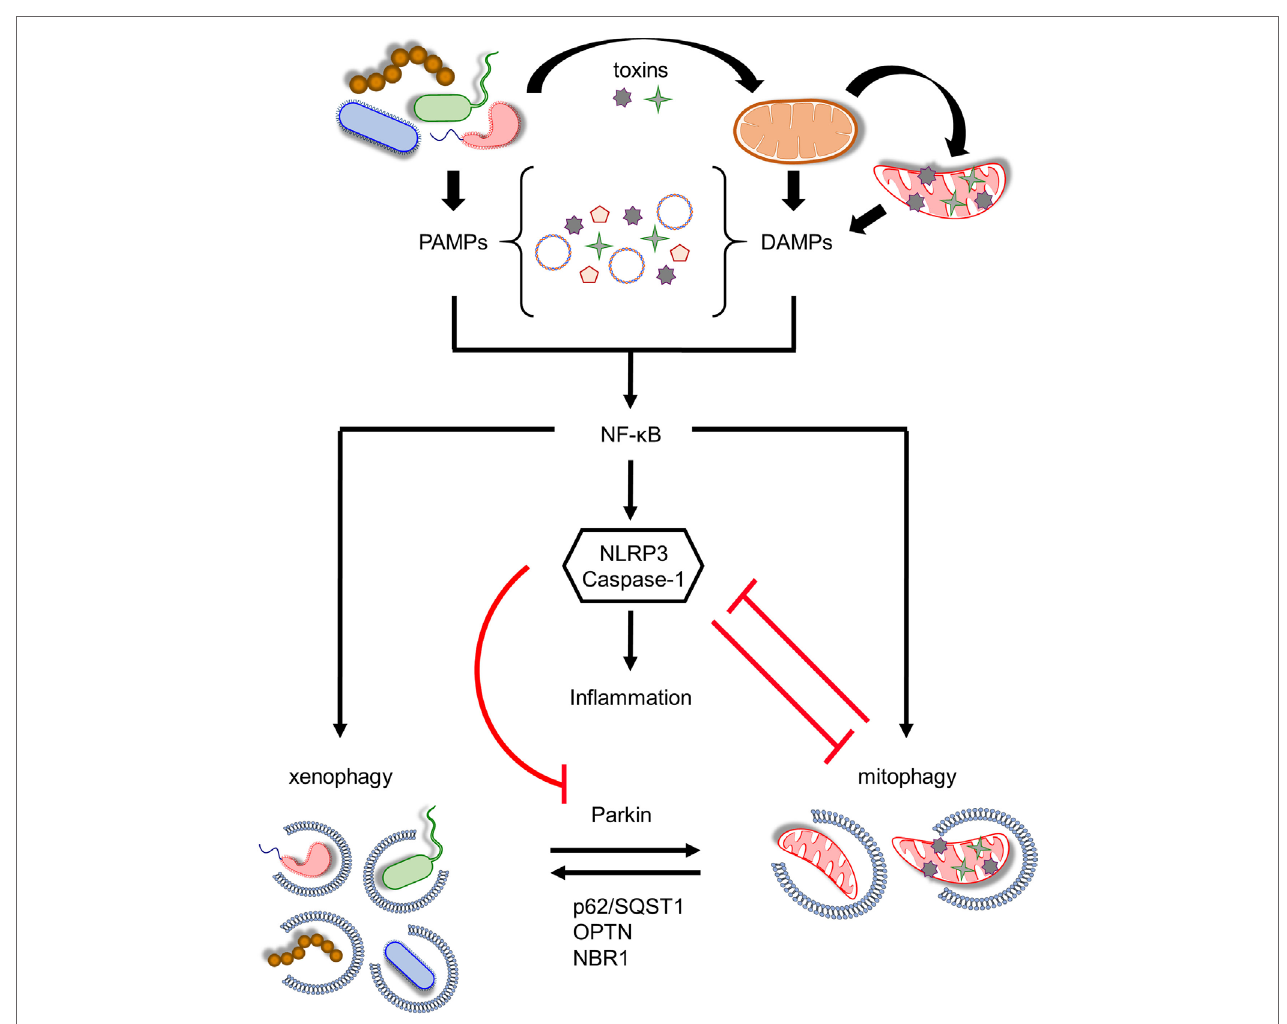
FiGURe 2 | Coordination between mitophagy and xenophagy during infection. Pathogen-derived toxins and secreted proteins impair mitochondrial homeostasis leading to mitochondrial DNA and formyl peptides release and excessive generation of mitochondrial ROS. Consequently, pathogen-associated molecular patterns (PAMPs) and damage-associated molecular patterns (DAMPs) trigger nuclear factor- κ B (NF- κ B) transcription factor promoting immune responses through NLR family, pyrin domain-containing 3 (NLRP3) inflammasome activation and pro-inflammatory cytokines production. In parallel, NF- κ B establishes a self-limiting program to prevent persistent and uncontrolled inflammation by augmenting mitophagy and pathogen removal via xenophagy. NLRP3 stimulation amplifies mitochondrial defects by inhibiting mitophagy through the direct caspase-1-mediated proteolytic cleavage of Parkin. Mitochondrial and bacterial autophagic processes share several common regulatory factors, including Parkin, p62/SQST1, optineurin (OPTN), and NBR1 among others, highlighting their tight communication. This intricate interplay between energy metabolism and innate immune responses upholds cellular and tissue homeostasis and survival during pathogen